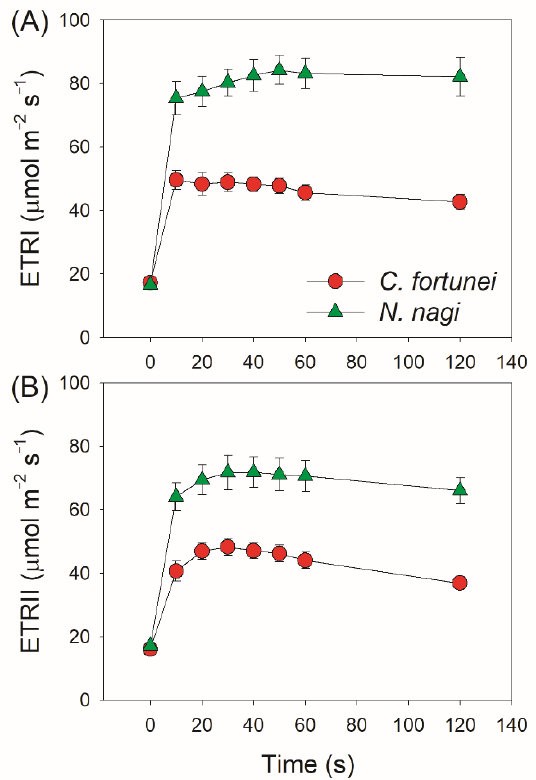
Figure 3. Changes in the photosynthetic electron transport rates after transition from 59 (t = 0) to 1809 μmol photons m −2 s −1 in leaves of Cyrtomium fortune and Nageia nagi . ( A ) ETRI represents electron transport rate through PSI; ( B ) ETRII, electron transport rate through PSII. The data are the means ± SE (n = 5).